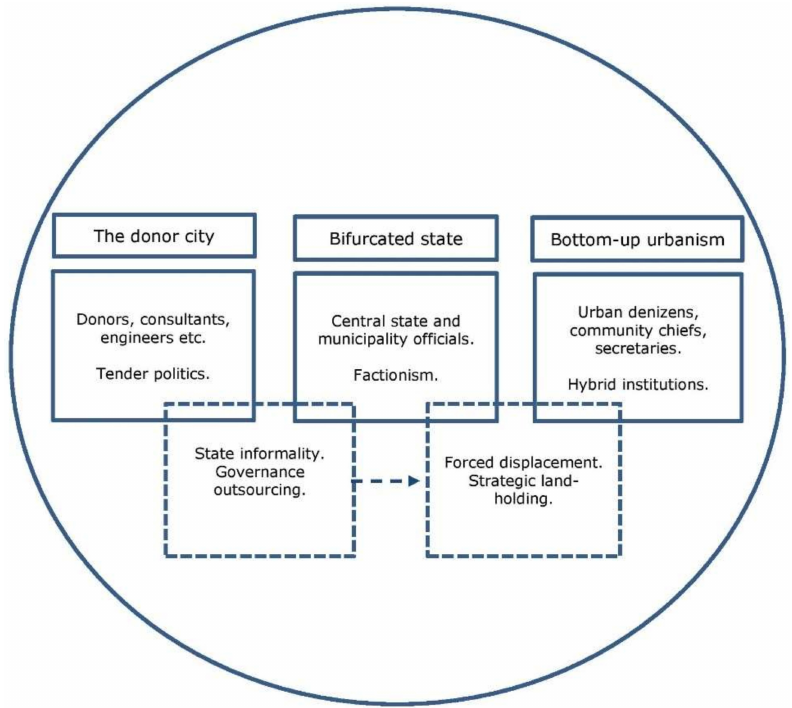
Figure 2. Conceptual model of the dimension and spaces of encounter in Beira’s contemporary urban